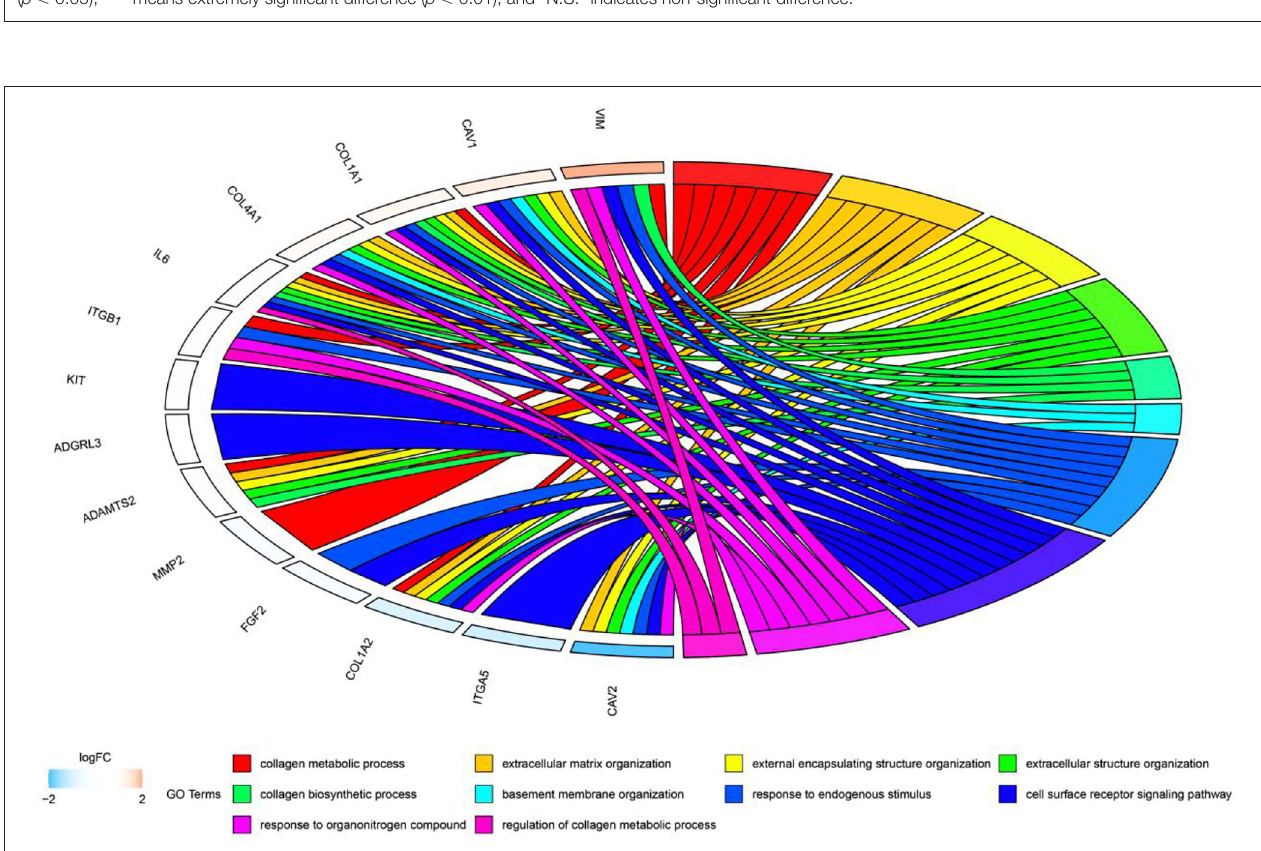
FIGURE 10 | The expression level of Hub gene in different differentiation stages of adipocytes. (A–E) Compared with that before induction, the expression levels of (A) CAV1, (B) ITGA5, (C) ABL1, (D) HSPG2, and (E) COL5A1 were significantly increased after induction. Compared with the control, “*” means significant difference